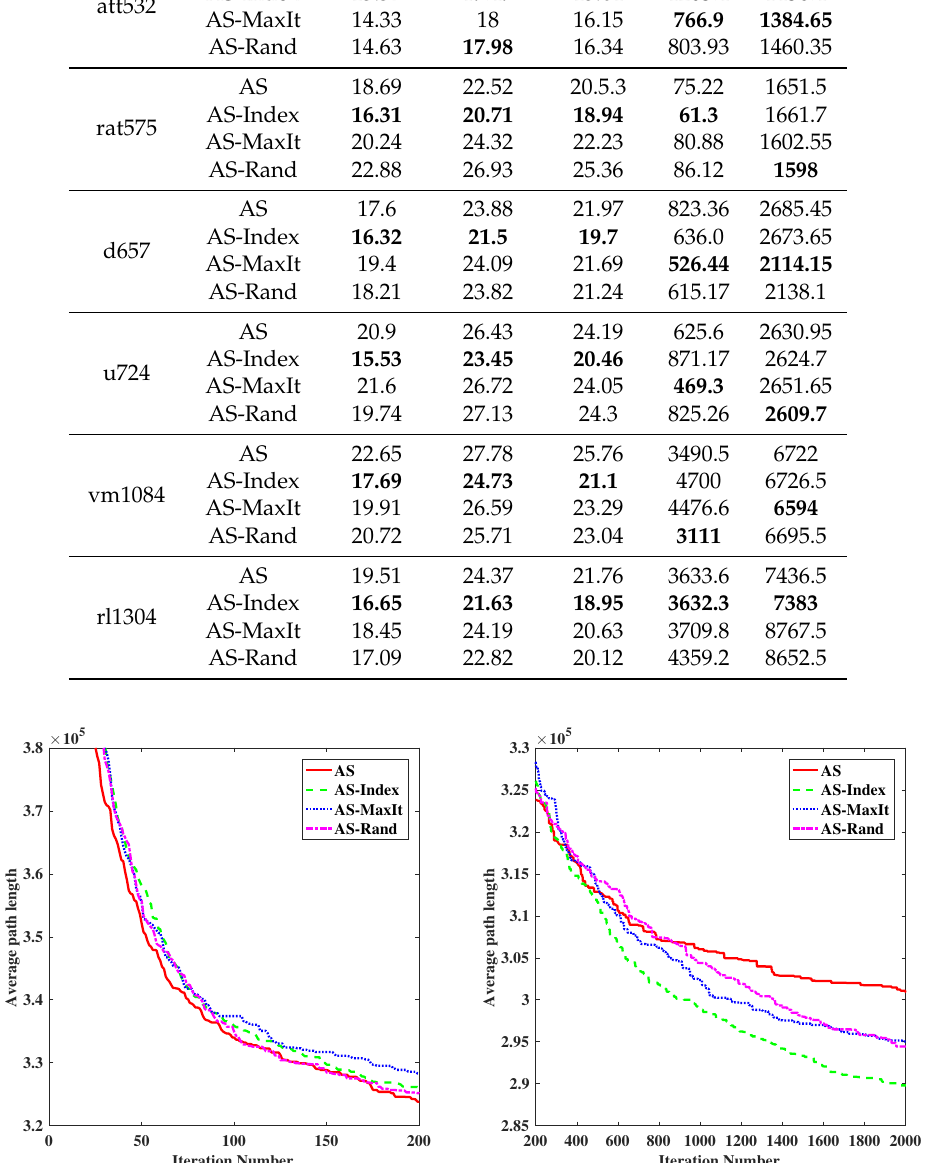
Figure 3. Evolutionary curves for different iteration periods based on